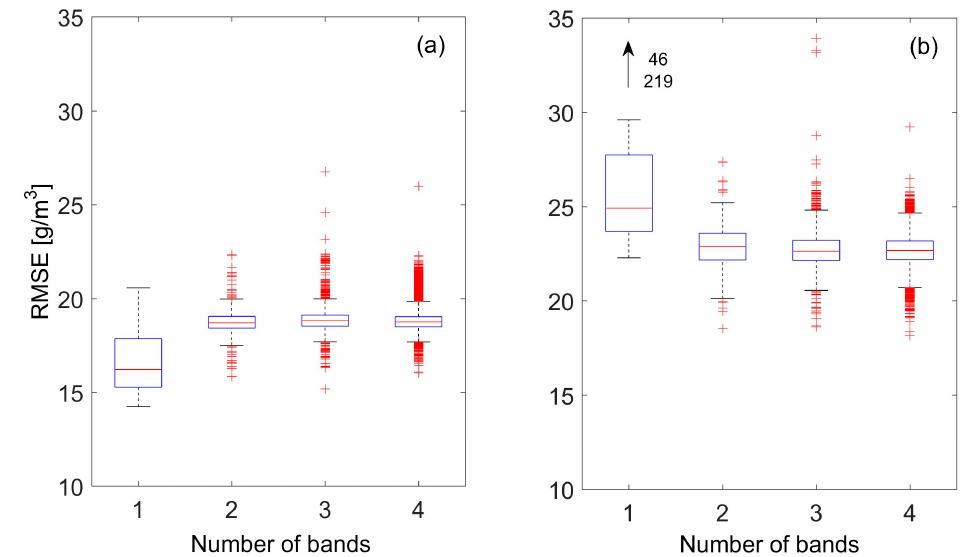
Figure 6. Root-mean-square error (RMSE) obtained from calibration ( a ) and validation ( b ) of the inversion of the radiative transfer model (Equation (8)) using combinations of different number of Hyperion bands. In the box-whisker plots, the red central line is the median, the edges of the box are the 25th and 75th percentiles, the whiskers extend to the extreme data points within approximately ±2.7 standard deviation from the mean (covering 99.3% data), and outliers are plotted as red crosses. Out of range data (indicate complete model failure) are represented with an arrow and the corresponding RMSE values are reported next to it.